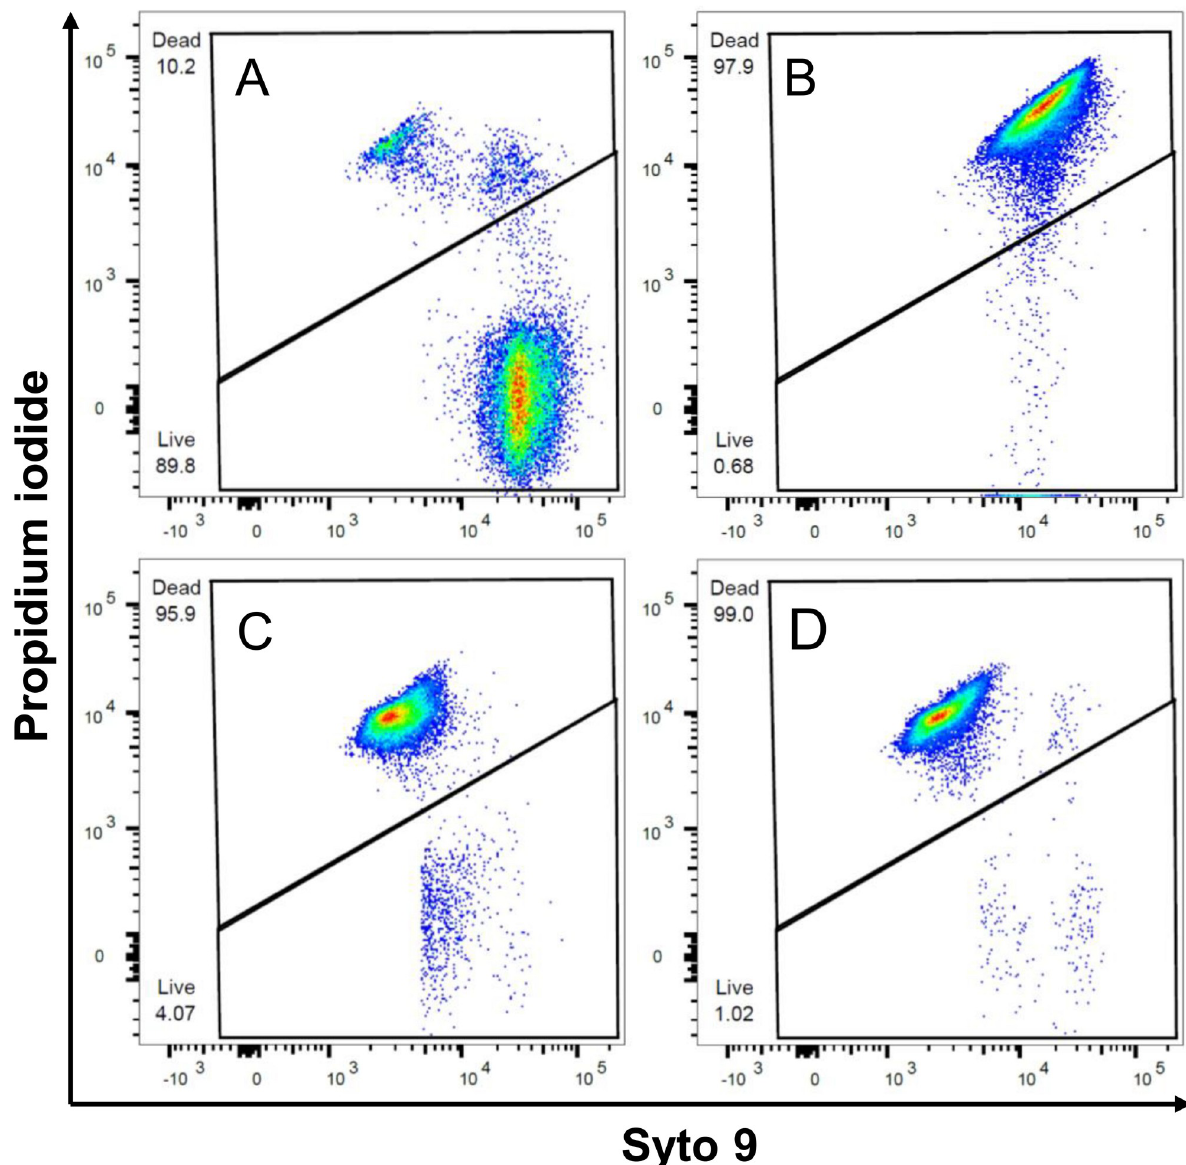
Fig 4. Flow cytometric analysis confirmed that both bNK2A peptides induced damage to Histophilus somni membranes. Live and dead H . somni in PBS control (A, PBS), heat-killed at 56˚C for 10 min (B), and treated with 20 μ M bNK2A-C10C20 (C), or 20 μ M bNK2A-S10S20 (D) at 37˚C for 30 min were stained with LIVE/DEAD Bac Light bacterial viability dyes. X-axis indicates live bacteria (Syto 9) and Y-axis indicates dead bacteria (propidium iodide). Results of one representative experiment out of three are shown. https://doi.org/10.1371/journal.pone.0218507.g004 Table 1. Mean percentages of dead Histophilus somni in bNK2A peptides treated samples as assessed by flow cytometry.